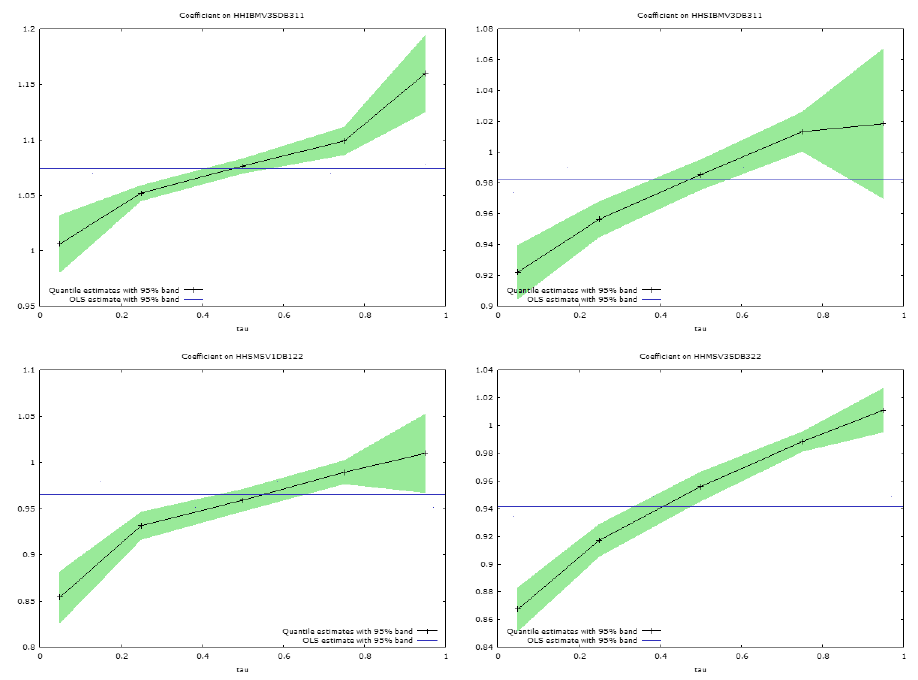
Figure 6. Quantile regression slope coefficient estimates of conditional variance from Full BEKK regressed on DBEKK estimates (remaining